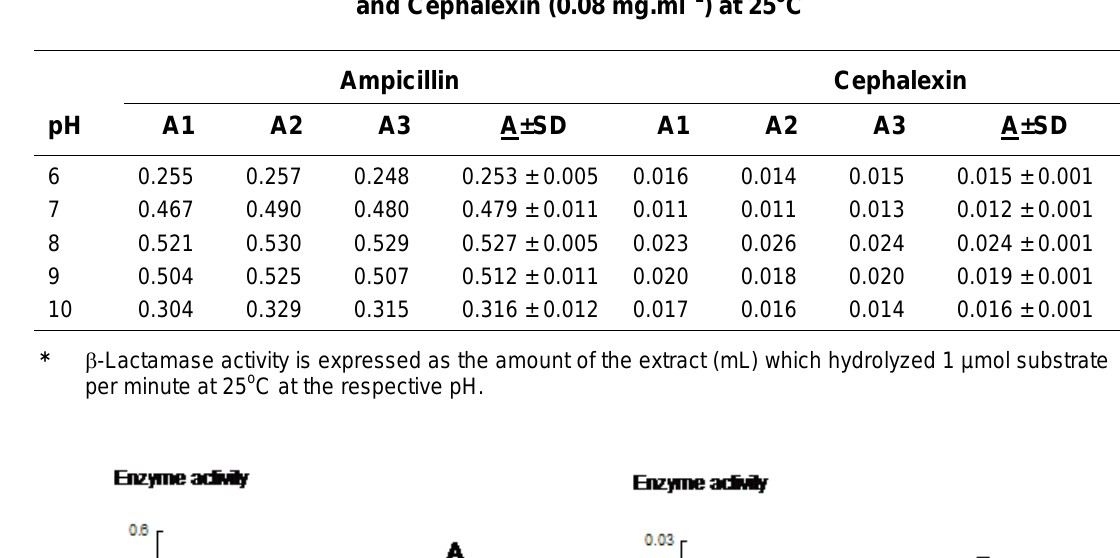
Effects of pH on β -Lactamase Activity* of the Crude Extract Against Ampicillin (2 mg.ml –1 )